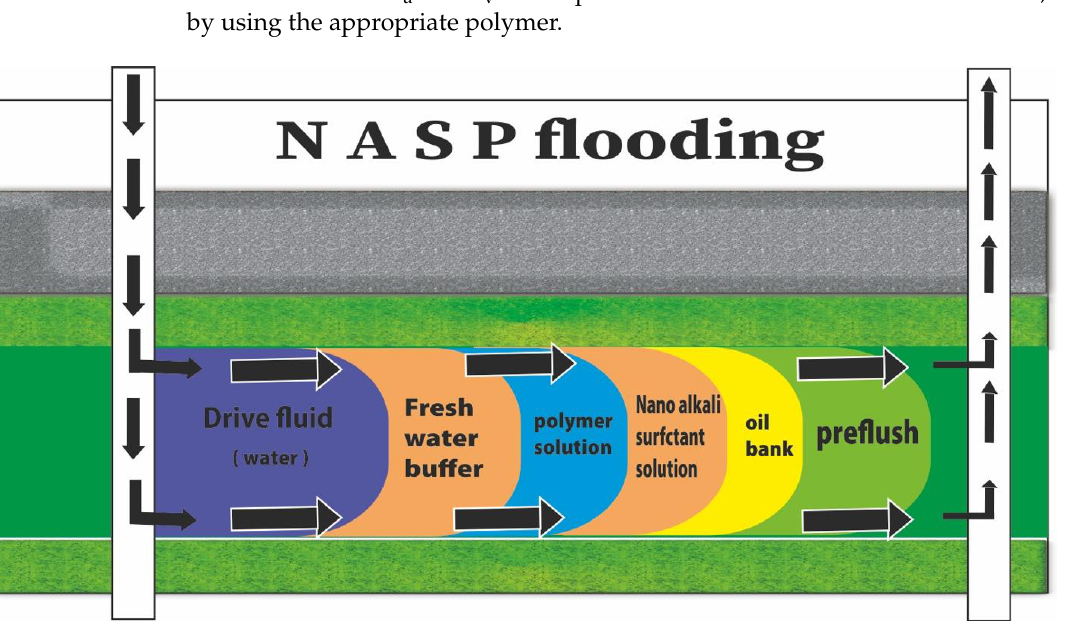
Figure 3. ASP chemical flooding sequence for enhancing oil recovery. ASP EOR injection is shown in sequence at the beginning, the preflush is injected then followed by oil bank; after that, nano-alkaline-surfactant is injected to decrease the IFT followed by a polymer to control the mobility via increasing the viscosity; finally, water drive is used to push the solutions. Table 3. NASP oil recovery efficiency prediction and efficiency of ASP alone and in